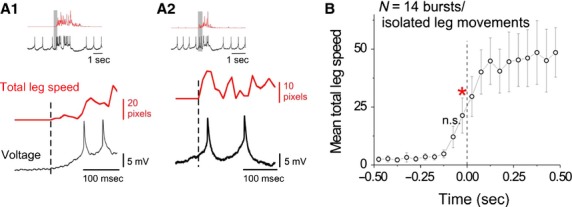
Increases in DA-DN spike rate follow movement onset. (A1–A2) Total leg speed (red) and DA-DN voltage (black) are plotted for the same trials shown in Fig.2B1–B2. The same data shown in Fig.2 are re-plotted in the top row here, with the time range indicated by the gray shading shown on an expanded time scale below. (B) For isolated leg movements, the onset of movement is aligned to the timing of the first DA-DN burst spike that accompanies the movement. This analysis reveals that DA-DN burst spikes, on average, follow movement onset (N = 14 DA-DN bursts/isolated leg movements; red asterisk indicates first prespike time bin in which total leg speed is significantly higher than baseline; P < 0.01, Tukey's HSD performed after one-way ANOVA with repeated measures).